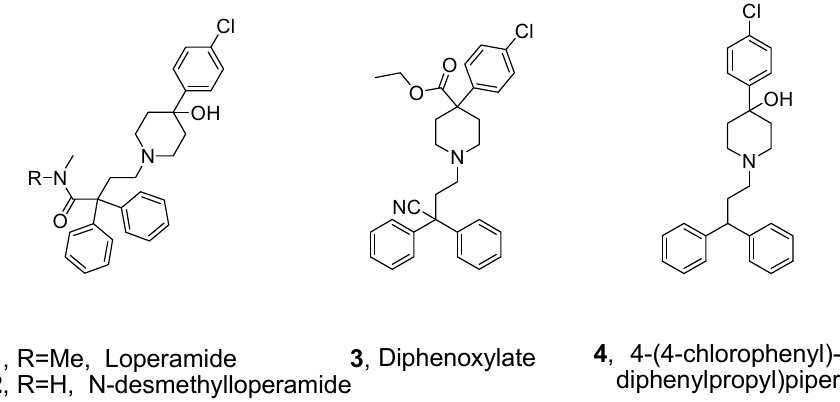
Figure 1. Structures of representative MOR agonists.